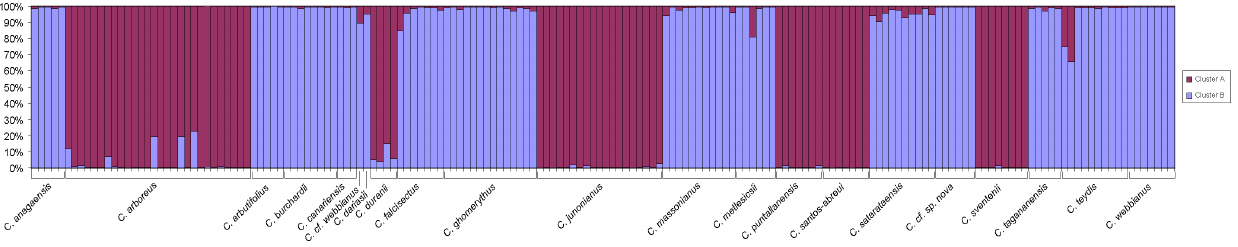
Figure 4. Results of STRUCTURE analyses of the entire AFLP dataset with K =2. Bayesian estimation of genetic structure within Macaronesian Cheirolophus according to the best model proposed by STRUCTURE ( K =2).